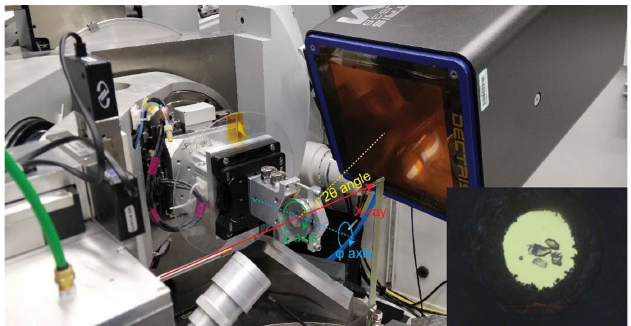
Figure 3 Geometry of the high-pressure single-crystal diffraction experiment at APS 13-BM-C. X-ray direction together with ’ , (cid:7) and 2 (cid:2) angles are labelled. Inset: image of the DAC sample chamber after He gas loading, showing four Lb crystals and one ruby sphere. The diameter of the sample chamber was 0.274 mm, indicated by the red scale